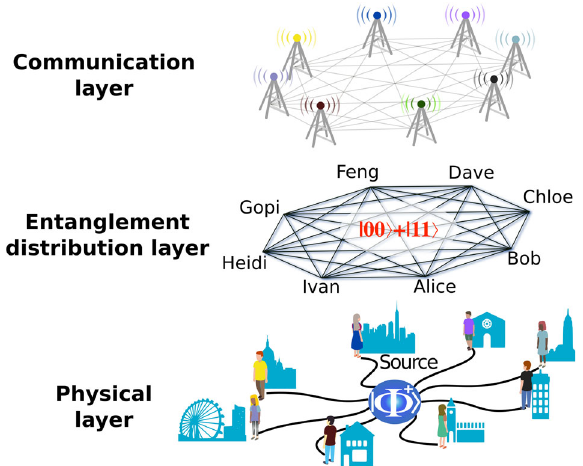
Fig. 1 Overview of the quantum network test bed. The physical layer consists of a broadband source of bipartite polarisation entanglement that is multiplexed and distributed to several users via one fi bre each. In the entanglement distribution layer, polarisation entangled states are distributed to, and measured by each user. In the communication layer, they perform classical communication to generate the QKD keys, and execute the anonymous protocols described in this paper.